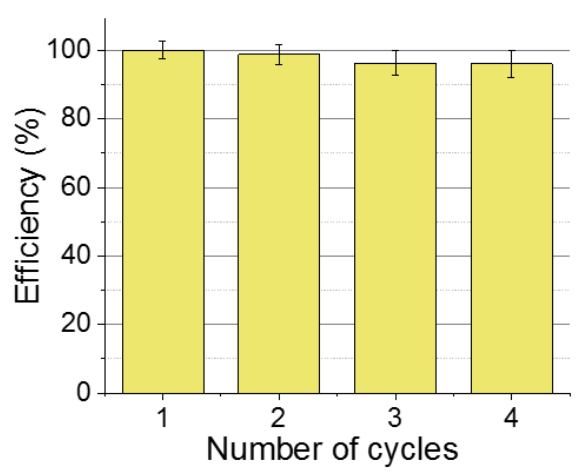
Figure 9. NPs reusability tests for chromium (VI) removal.